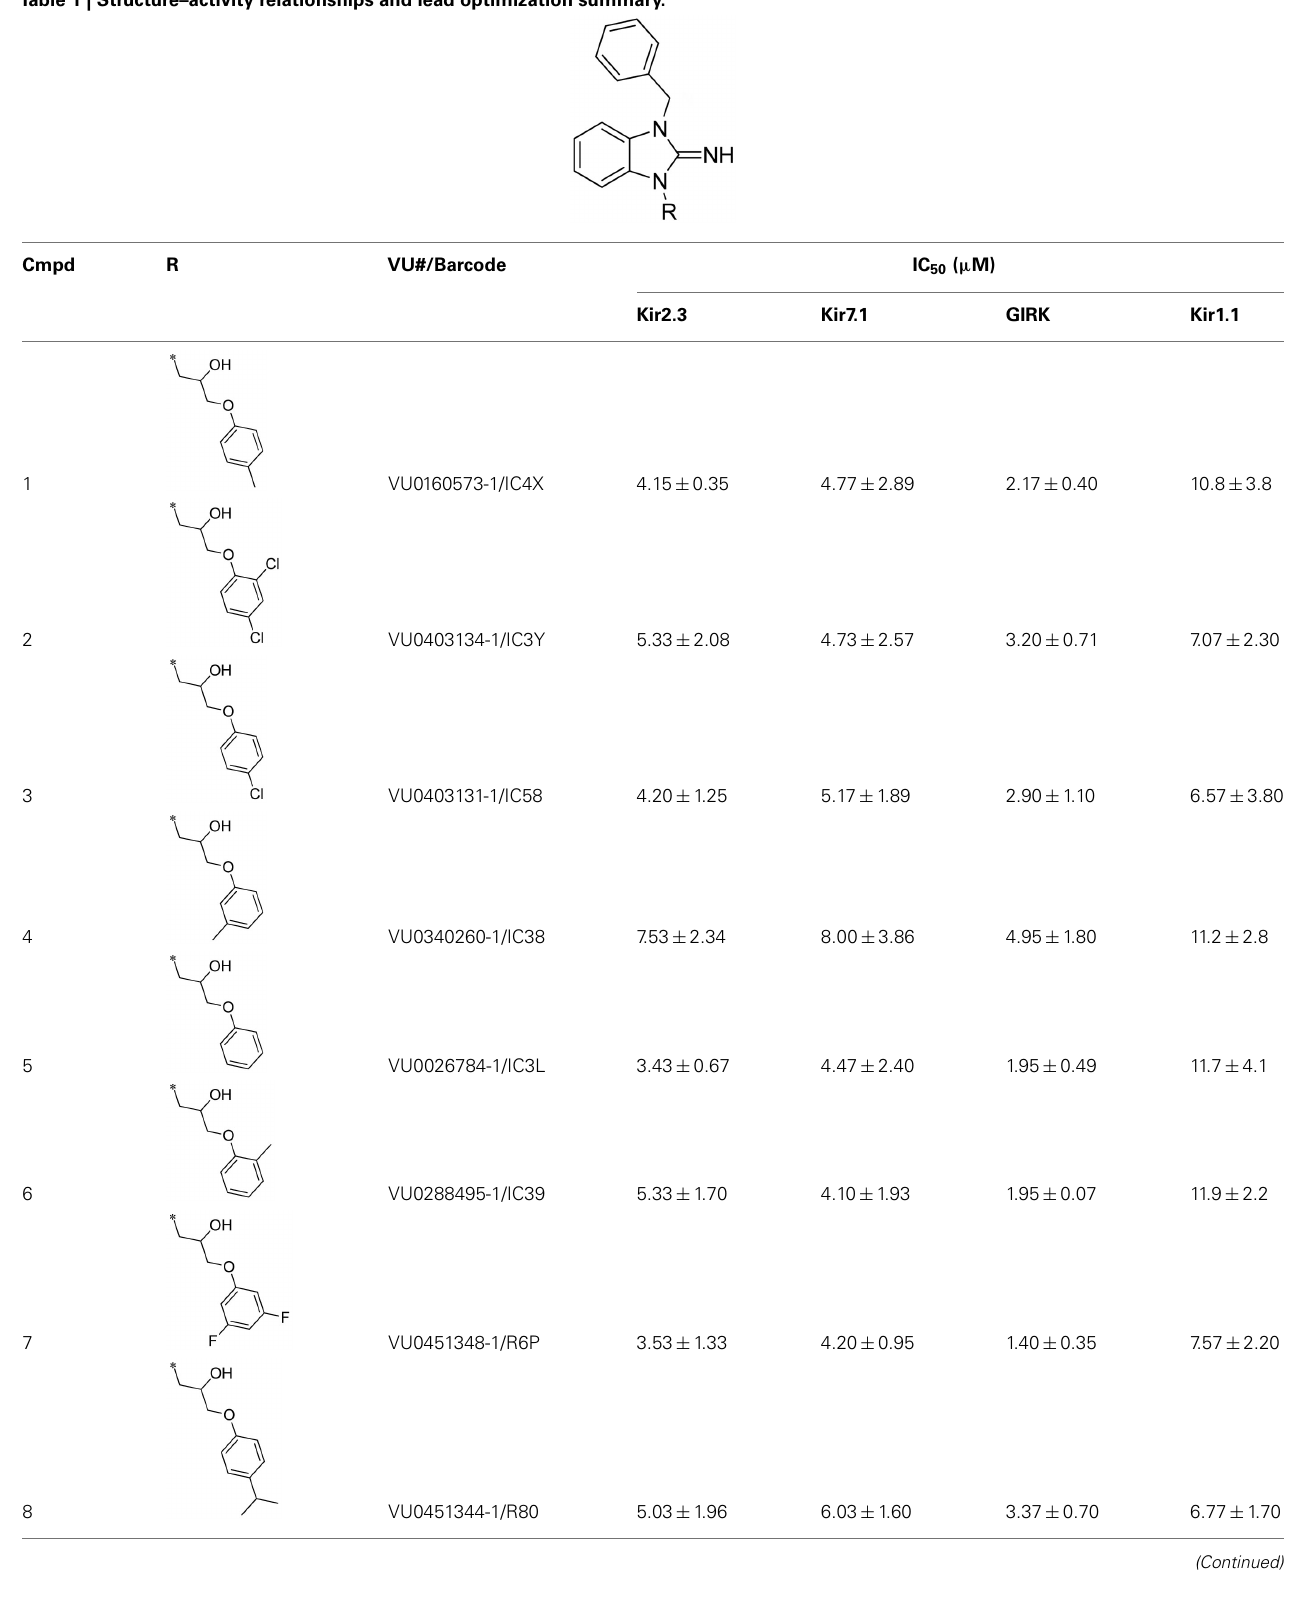
Table 1 | Structure–activity relationships and lead optimization